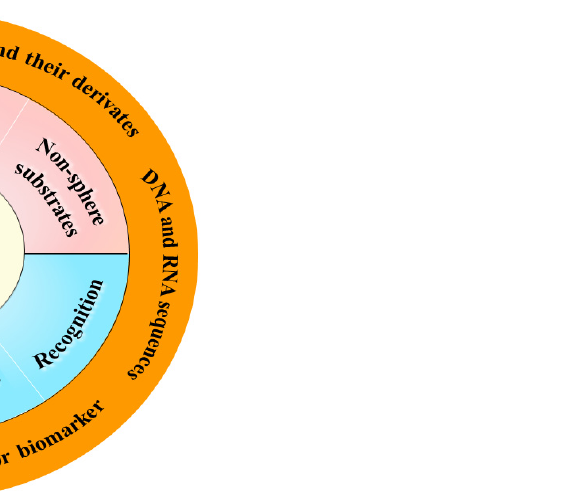
Figure 1. Schemic of magnetic nanoparticle-based SERS substrates for analysis of typical biotargets.